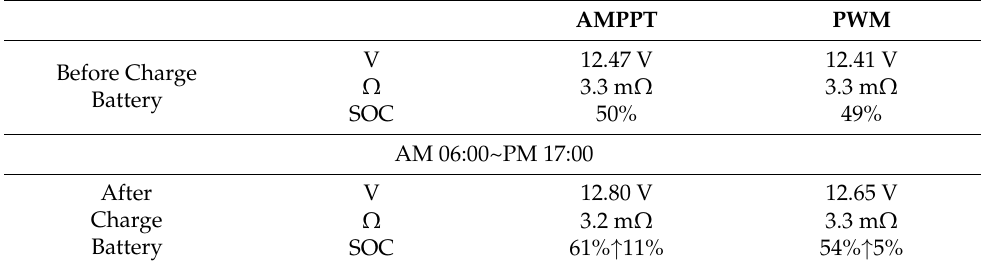
Table 2. Case 2: battery SOC before/after.